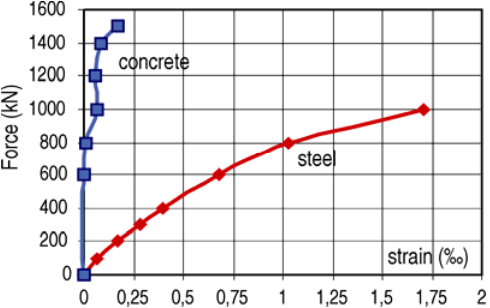
Fig 6 . Strains of steel and concrete in cross-section situ- ated 5 cm from the upper edge